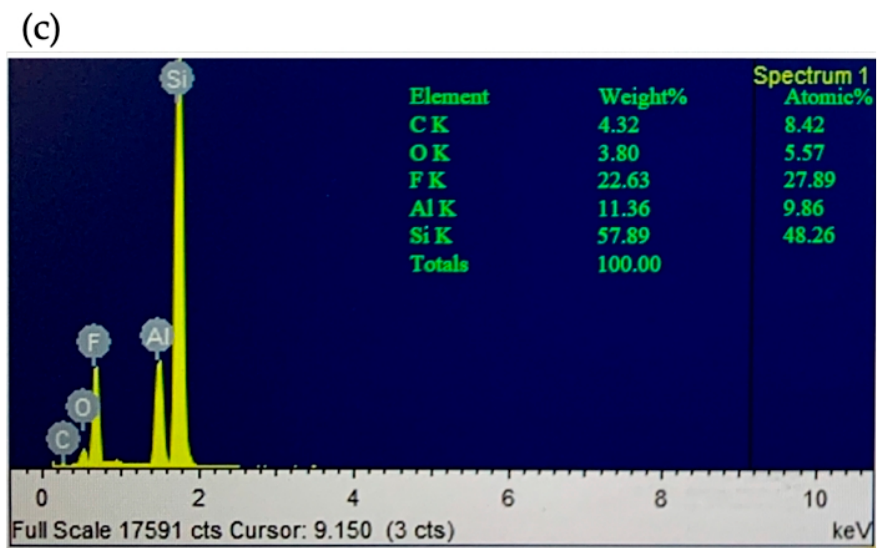
Figure 1. Results of scanning electron microcopy (SEM) and energy-dispersive X-ray spectroscopy (EDX) analyses of the edge particle residue on a 12-inch (30.48 cm) wafer as well as relevant infor- mation related to by-products. ( a ) SEM and EDX maps of particles adhering to a wafer surface after etching. These particles are often visible around the edges of etched wafers in the chamber. Particles (A), (B), (C) in three positions are selected to check the shape, as shown in ( b ). ( b ) SEM images of particles (A), (B), (C) in ( a ) with a scale bar of 6 micron. ( c ) EDX spectra used to analyze silicon, fluorine, and aluminum concentrations in the particles. The y-axis indicates the number of X-rays, and the x-axis indicates the energy of the X-rays. The yellow peaks in the spectra correspond to different elements of the particles (carbon, fluorine, and aluminum), and the peak heights can be used to quantify the concentration of each element.